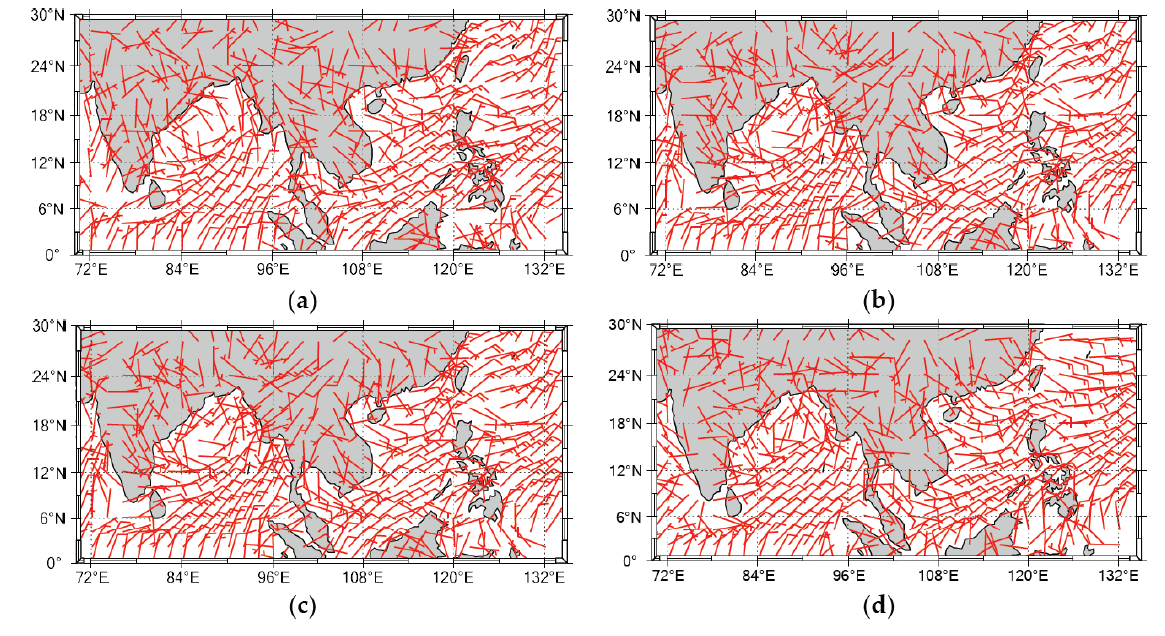
Figure 1. South Asia Wind Field Model, ( a ) wind state at 00:00, ( b ) wind state at 06:00, ( c ) wind state at 12:00, and ( d ) wind state at 18:00.